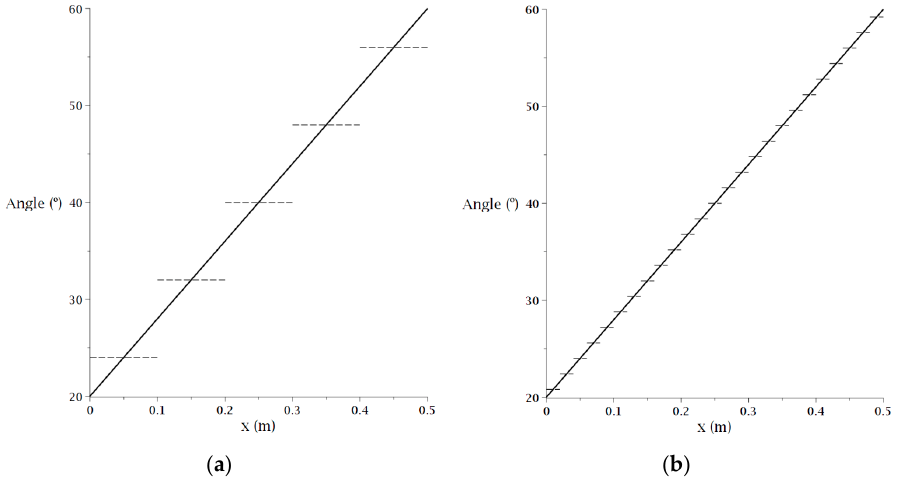
Figure 3. Angles discretization. ( a ) 10 × 10 mesh, ( b ) 50 × 50 mesh.